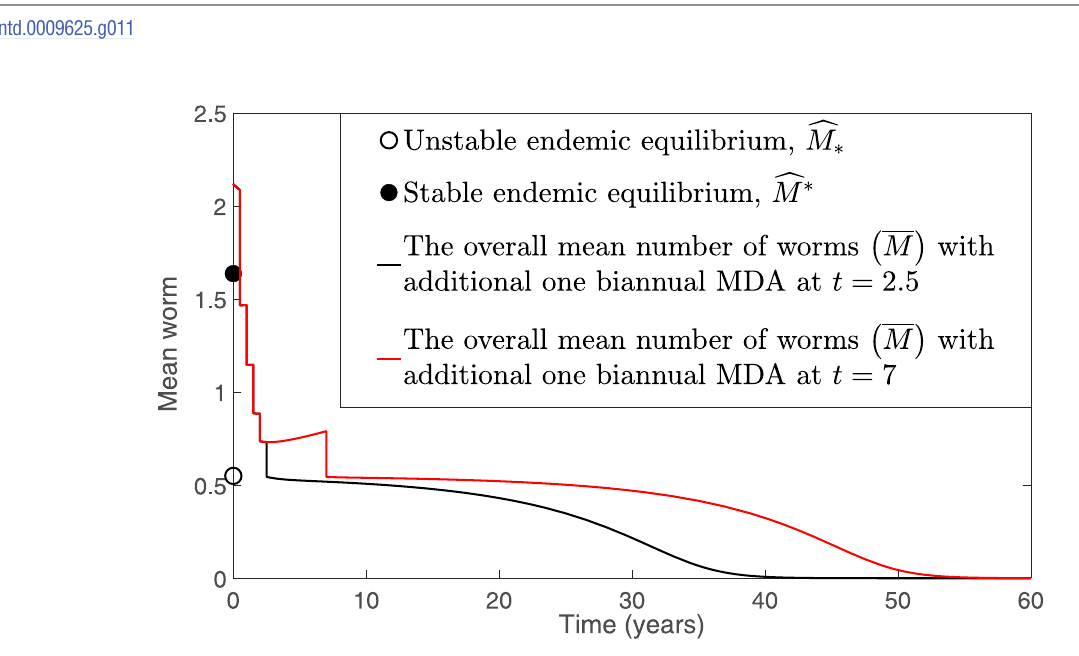
Fig 12. Numerical solutions of model (9) and (10) with an additional round of TUMIKIA community-based biannual deworming strategy.